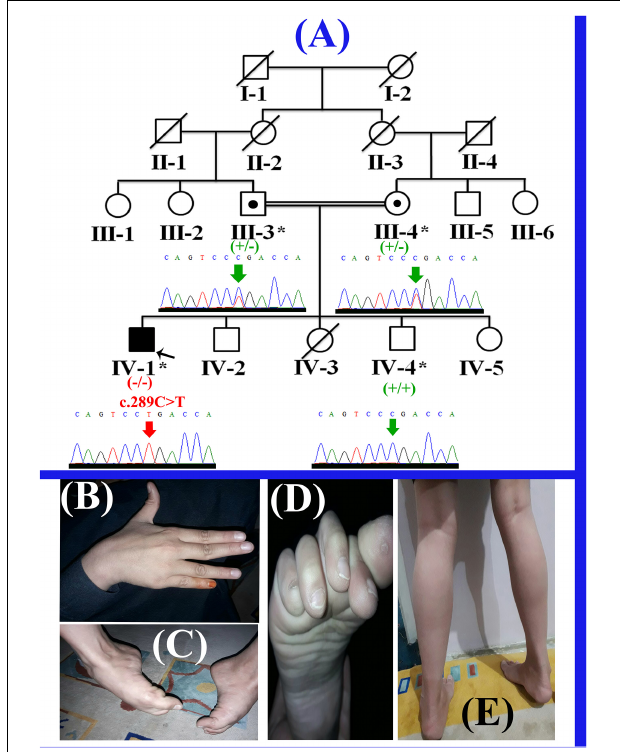
FIGURE 1 | (A) Pedigree of the present family, segregating autosomal recessive form of LGMD2F. Clear circles and squares represent normal females and males, respectively. Black symbol represents the affected individual (proband). Double lines indicate consanguineous union. Individual numbers labeled with asterisks, indicate those who were available for the present study. (B) Affected individual’s (IV-1) hand showing contractures. (C,D) Right foot of the affected individual (IV-1) showing fixed flection deformity and stiffness of the toes. (E) Feet showing the weakness in the gastrocnemius muscle and the inability to stand without